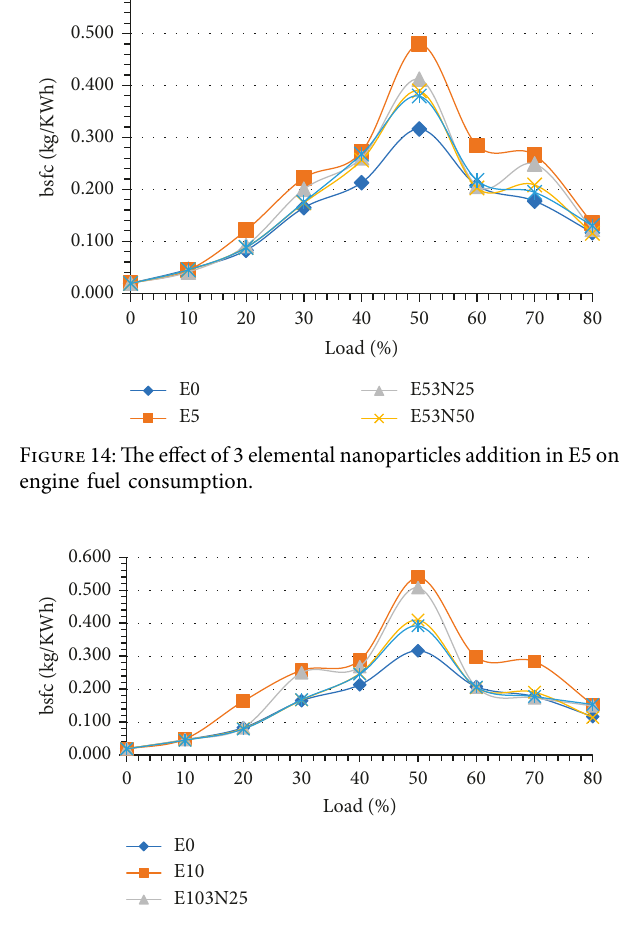
Figure 15: The effect of 3 elemental nanoparticles addition in E10 on engine fuel consumption.